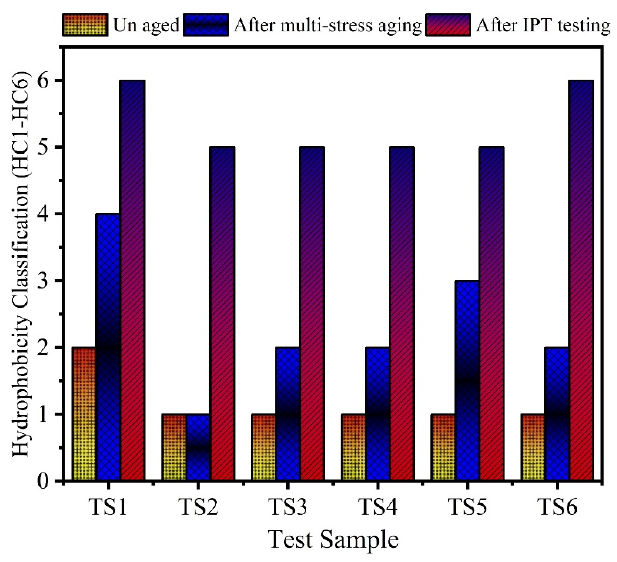
Figure 10. Hydrophobicity classification of the aged and unaged samples.